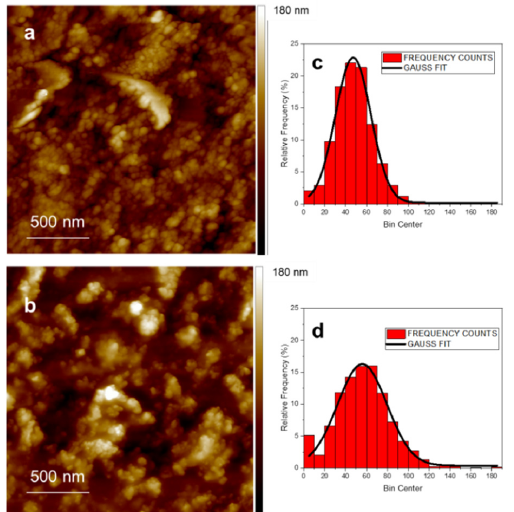
Figure 4. Non-contact representative AFM images (2 μ m × 2 μ m) of drop-casted ( a ) and MAPLE ( b ) films deposited on PDMS substrate; GL nanoparticle size distribution ( c , d ).